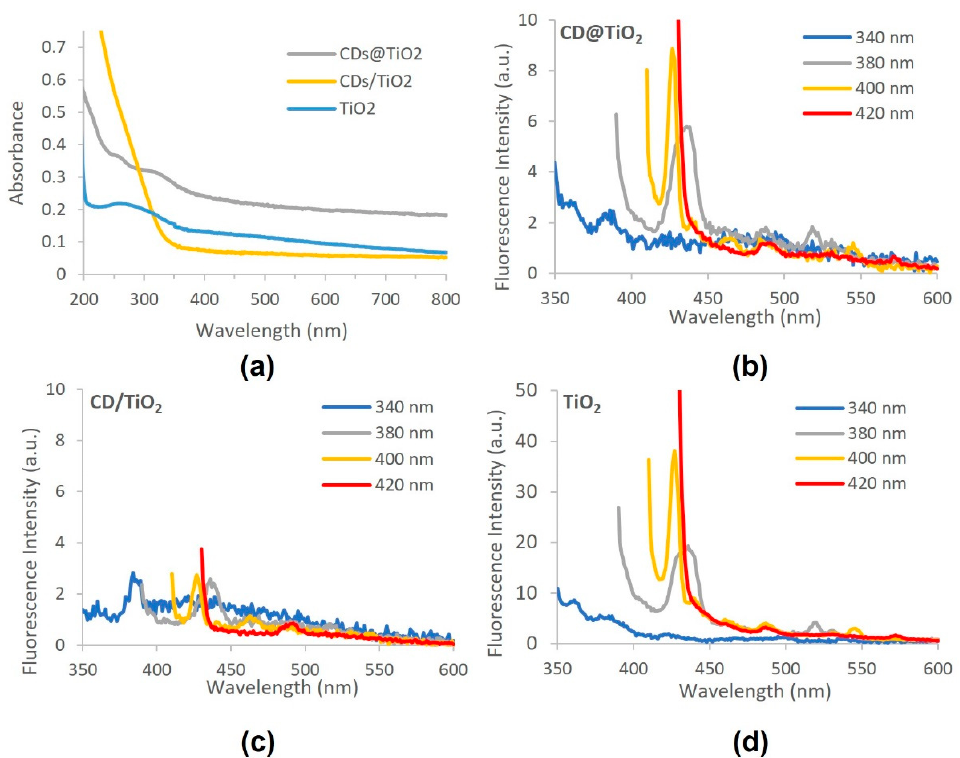
Figure 3. CD nanocomposites characterization by ( a ) UV-visible absorption (CD@TiO 2 , CD/TiO 2 and TiO 2 ); and ( b – d ) flu- orescence (CD@TiO 2 ( b ); CD/TiO 2 ( c ); TiO 2 ( d